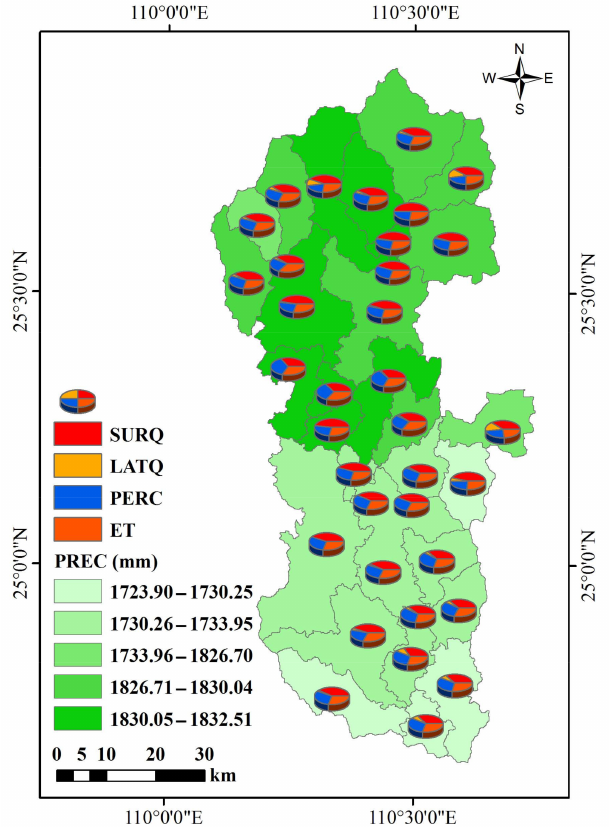
Figure 5. Water balance distribution map of the sub-basins (mm). SURQ is the surface runoff in the basin; LATQ is the lateral runoff; PERC is the recharge of soil to groundwater; and ET is the actual